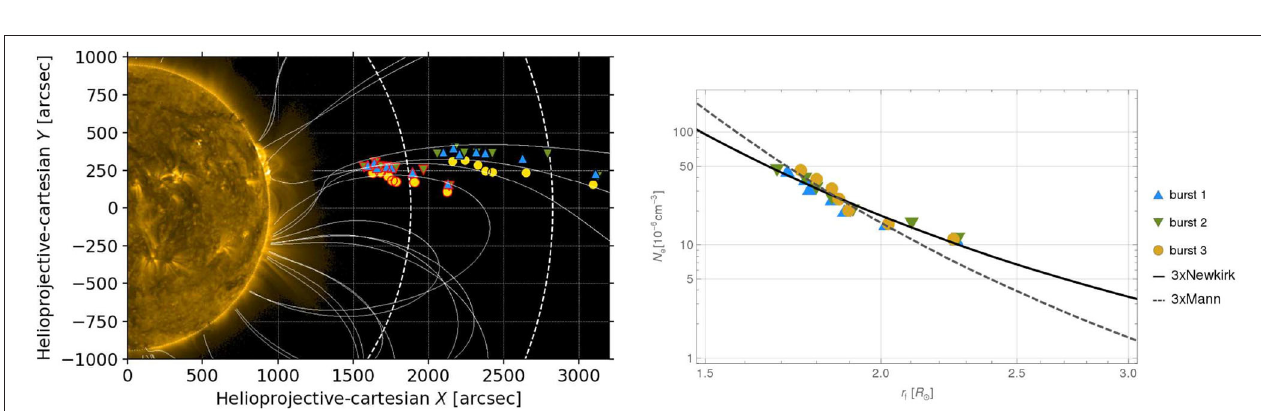
FIGURE 8 | Left : Type III centroids from a number of radio bursts at the fundamental (red outlines) and the harmonic. Right : Density models derived from the type III centroids. Adapted from Mann et al. (2018).